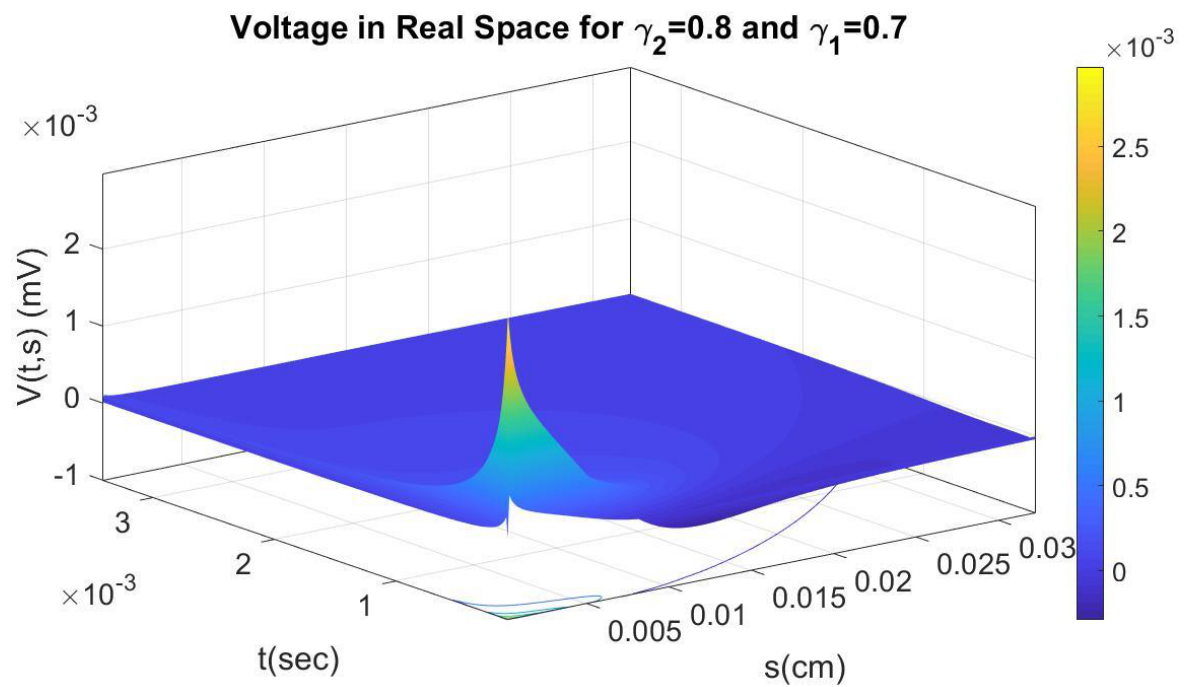
Figure 6. The voltage V(t,s) in real space as a function of time and arc length s, for fractional orders γ 2 = 0.8 and γ 1 = 0.9.